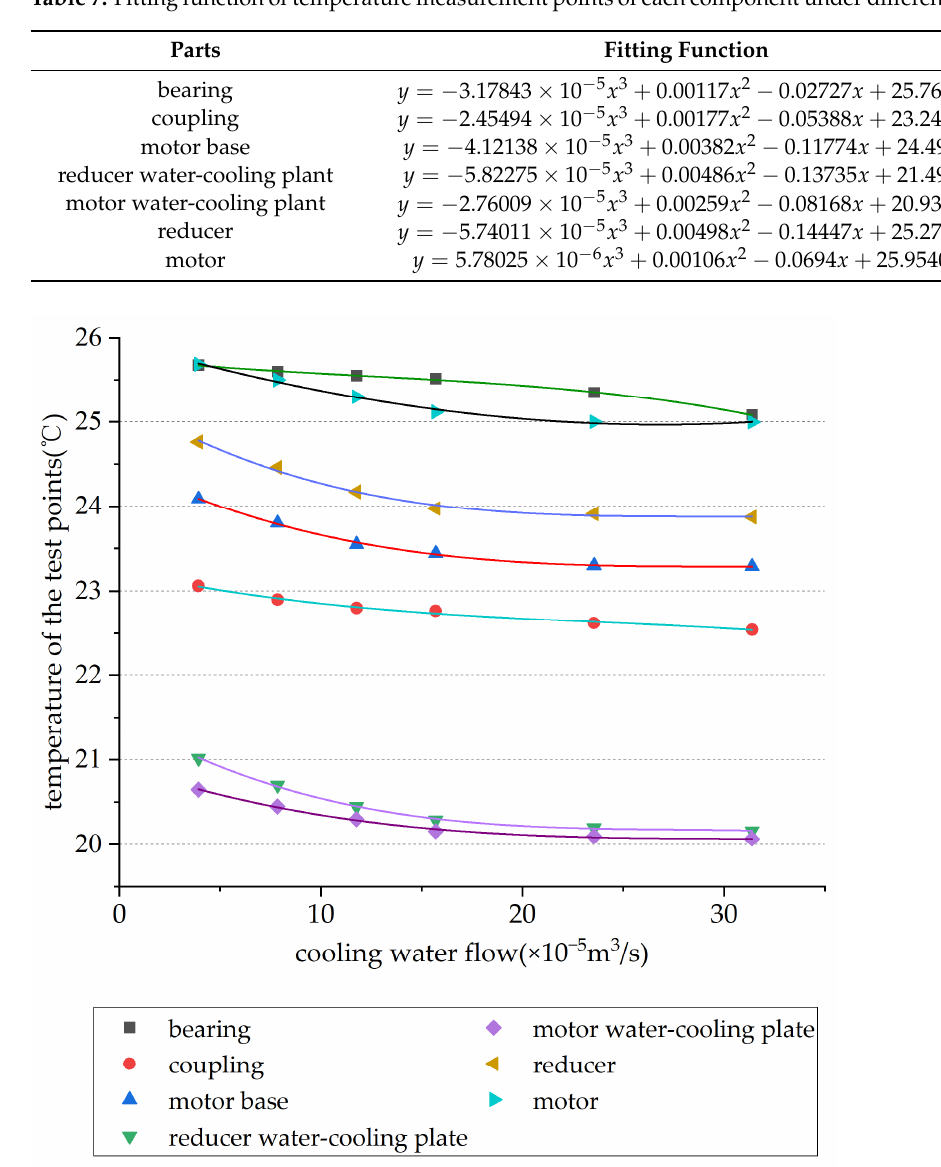
Table 7. Fitting function of temperature measurement points of each component under different flows.